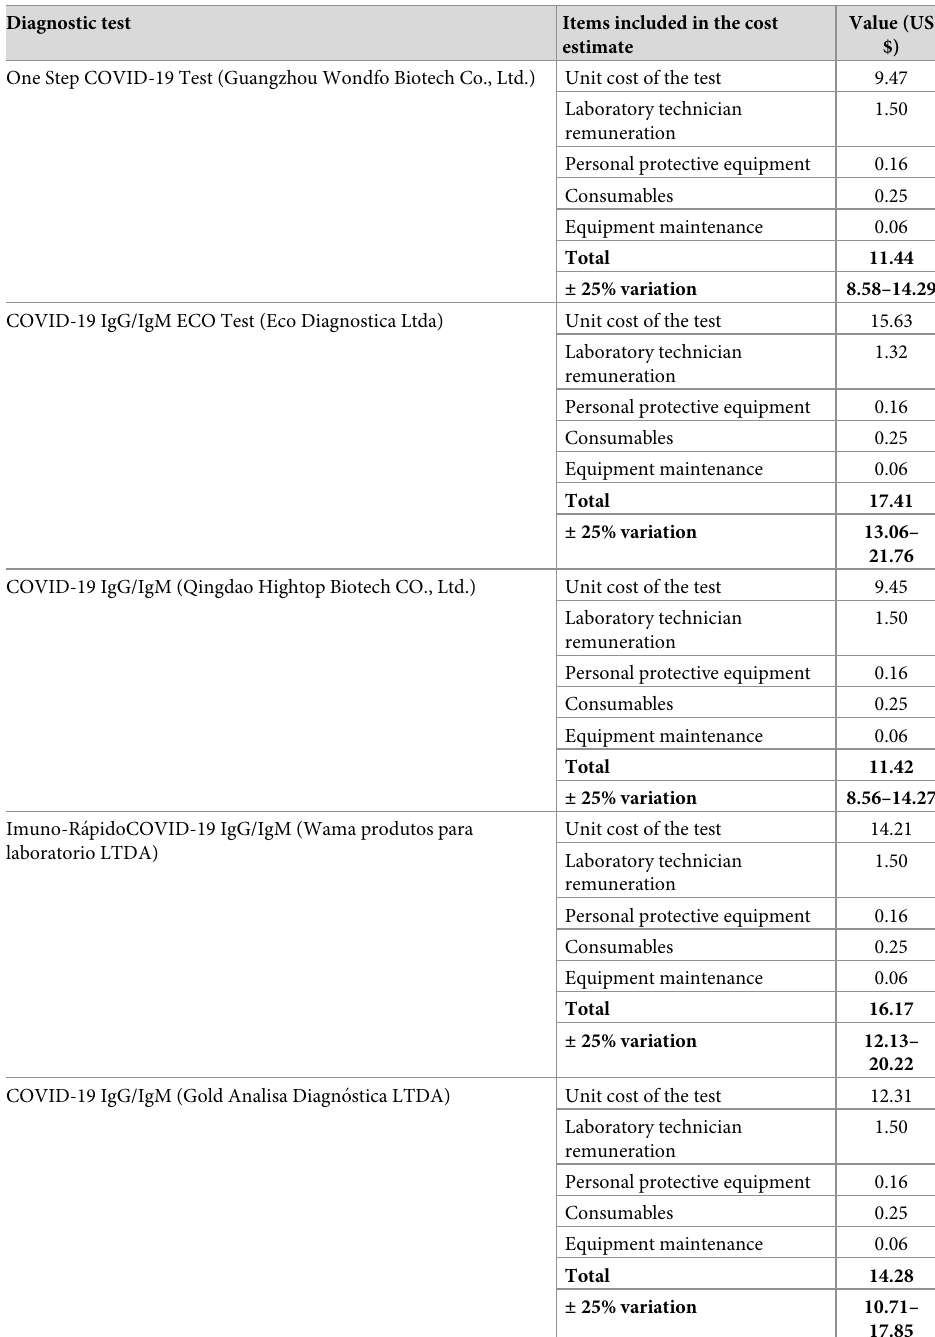
Value (US estimate $)